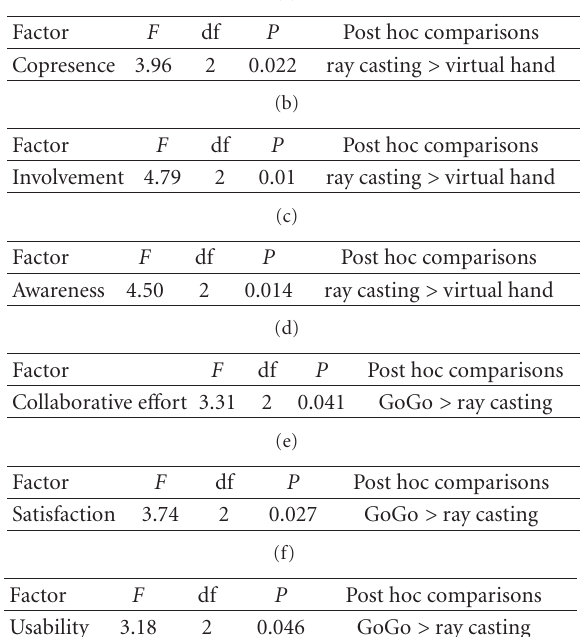
Table 1: Post hoc Comparisons between